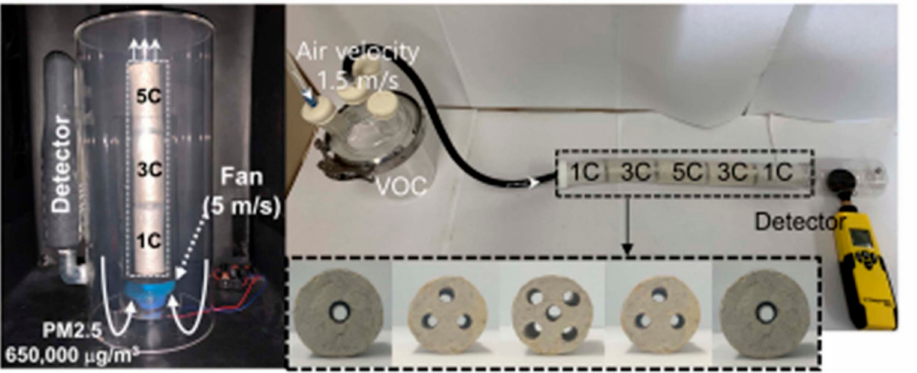
Figure 3. ( Left ) An image of the operation of an air cleaner equipped with CHAF-1C / 3C / 5C for the removal of PM 2.5 . ( Right ) Images of an air filtration system equipped with CHAF-1C / 3C / 5C / 3C / 1C and single cylindrical hollow air filters (CHAFs) (CHAF-1C, 3C, and 5C) for the removal of VOCs (HCHO). Reproduced with permission from [100]. Copyright 2020 American Chemical